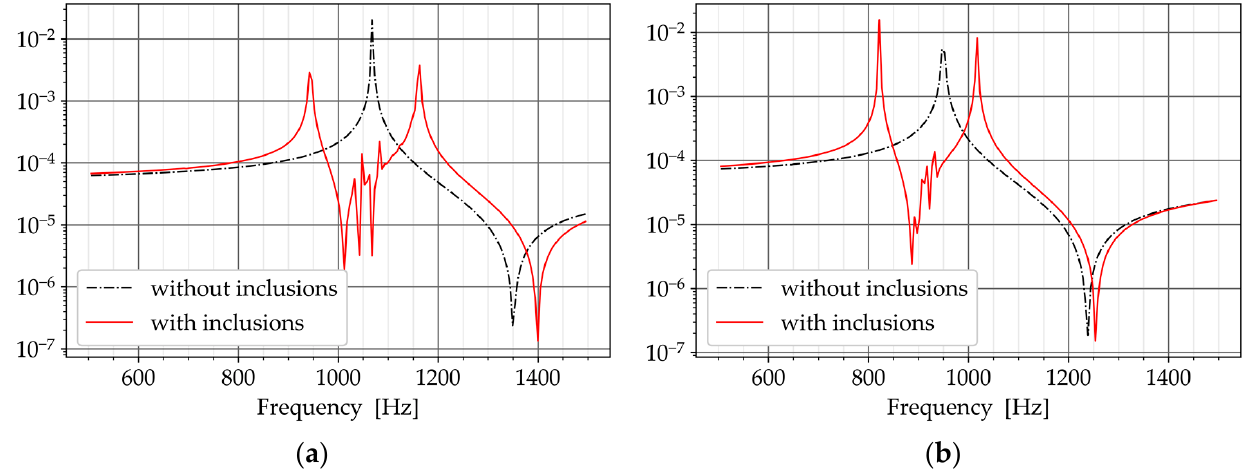
Figure 15. The response curve of the models with and without the inclusions. ( a ) P480. ( b ) P510.